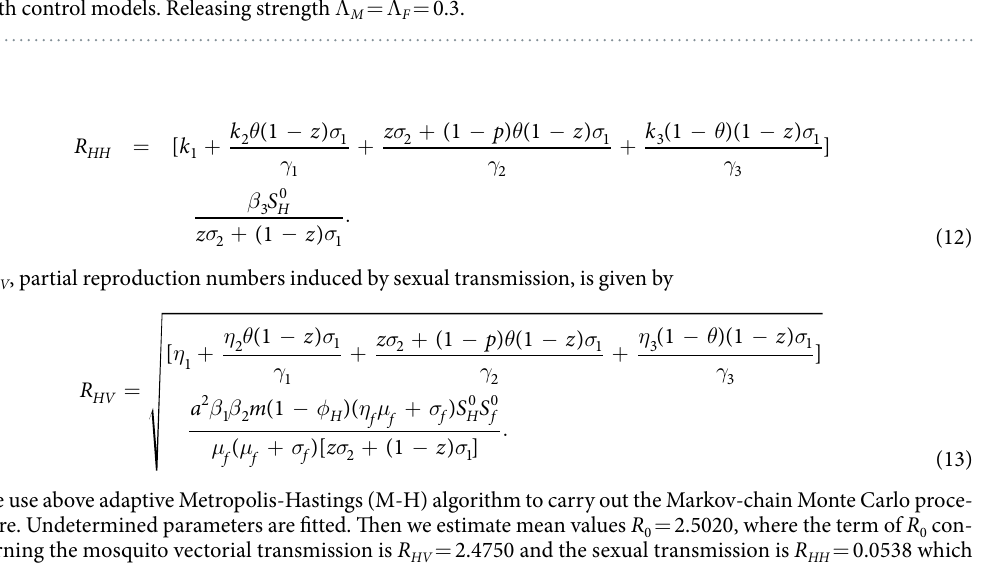
Figure 5. The effects of ( A ) simultaneously releasing Wolbachia-harboring female and male mosquitoes; ( B ) only releasing Wolbachia-harboring male mosquitoes. The initial human subpopulations are the same as Fig. 3. The initial mosquito subpopulations are A f 0 = A h 0 = 0.3, S f 0 = S h 0 = E f 0 = E h 0 = I h 0 = 0.1, M h 0 = 0.3, I f 0 = 0.15 for both control models. Releasing strength